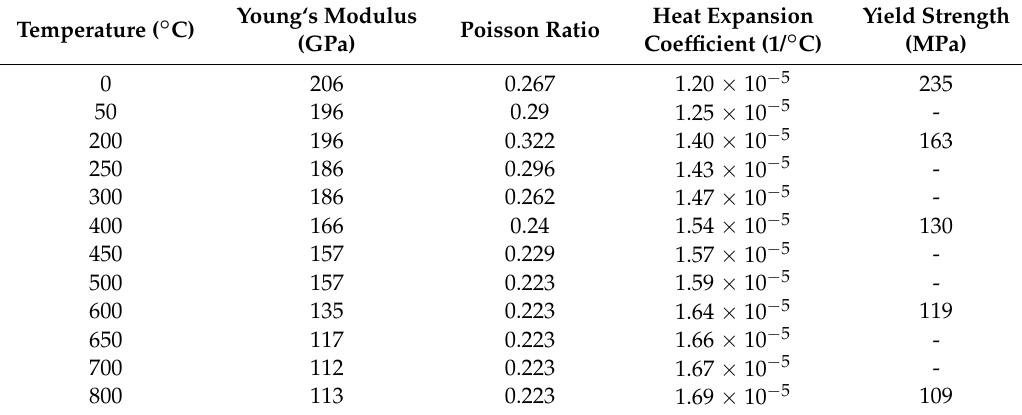
Table 2. Mechanical parameters of low carbon